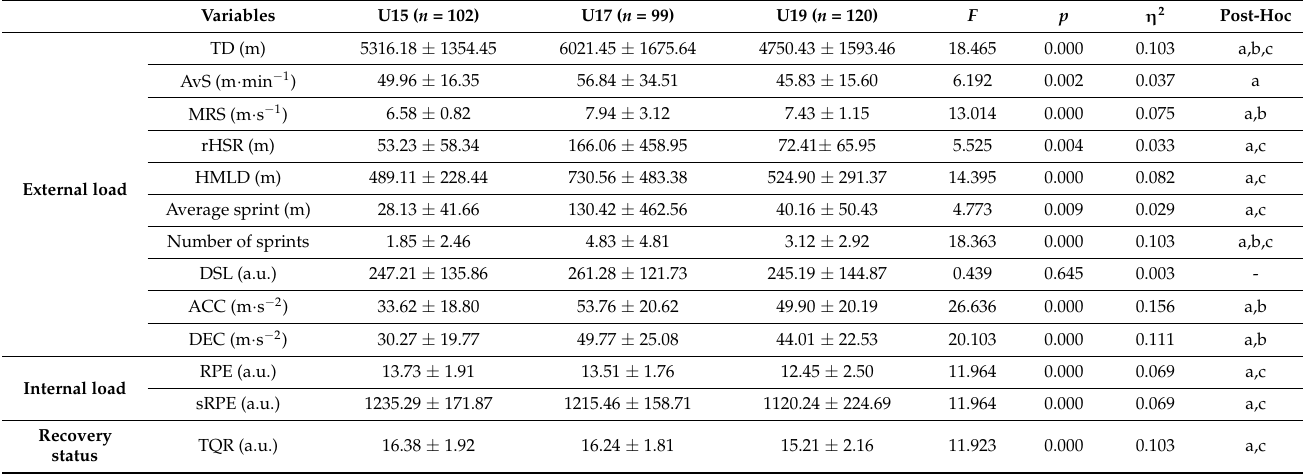
Table 1. Mean training load and recovery status per session for each age group